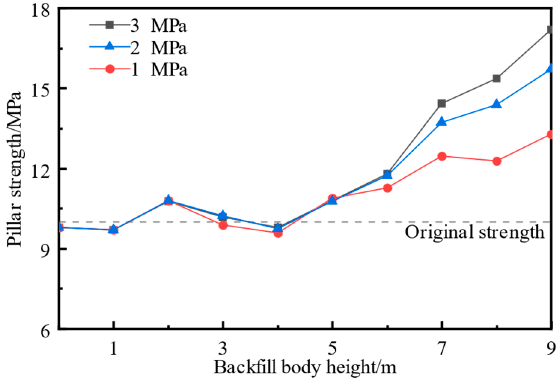
Figure 5. Coal pillar strength under different height conditions.